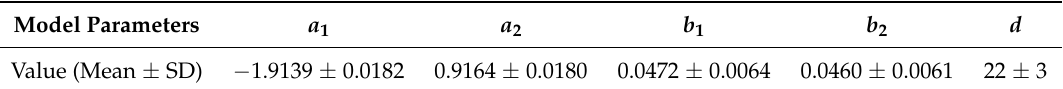
Table 2. Identified parameters of the antagonistic actuator.